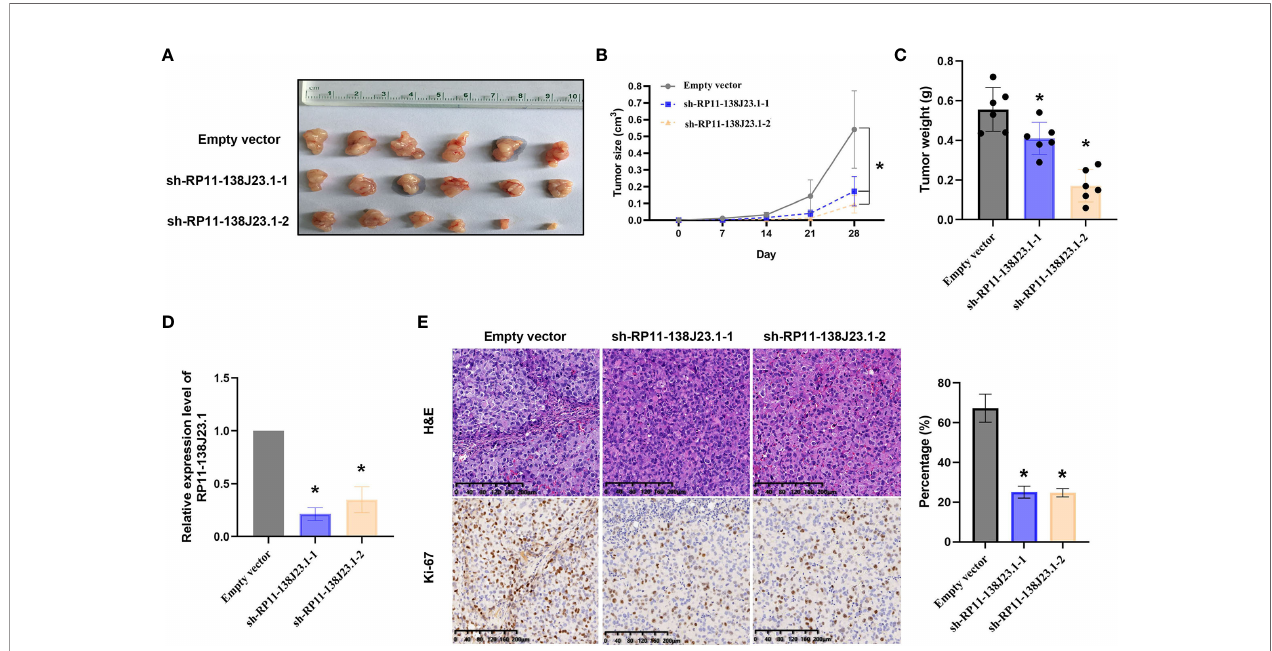
FIGURE 5 | The effects on tumor growth after RP11-138J23.1 downregulation in vivo . (A, B) The tumor growth curves were measured 7 days after the injection of BGC-823 cells stably transfected with shRNA-RP11-138J23.1 1#, shRNA-RP11-138J23.1 2#, or empty vector, and tumor volume was calculated once every 7 days. (C) Tumor weight when the tumors were harvested. (D) qRT-PCR analysis of RP11-138J23.1 expression level in tumor tissues formed from shRNA-RP11- 138J23.1 1#, shRNA-RP11-138J23.1 2#, or empty-vector-transfected BGC-823 cells. (E) Representative images of HE staining and Ki-67 immunohistochemistry of the tumor. up, H & E staining; down, immunostaining. The data represent the mean ± SD from three independent experiments. * p <